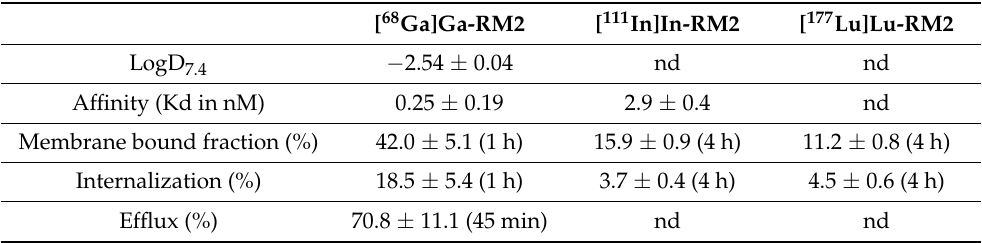
Table 3. Comparison of in vitro radiopharmaceutical properties of [ 68 Ga]Ga-RM2 over [ 111 In]In- RM2 [20] and [ 177 Lu]Lu-RM2